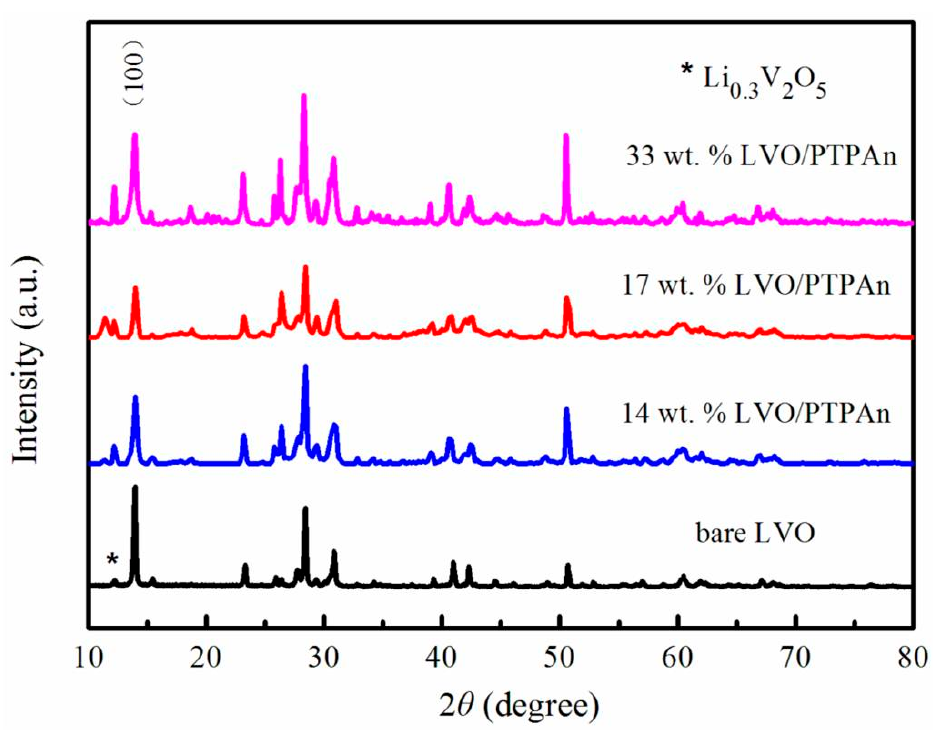
Figure 7. XRD patterns of the bare LiV 3 O 8 sample and LiV 3 O 8 /Polytriphenylamine (PTPAn) compo- sites Reprint with permission [68] © 2017 by the authors. Licensee MDPI, Basel, Switzerland.